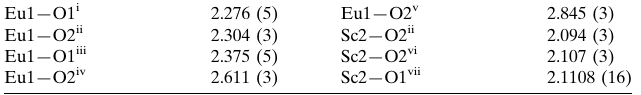
Selected bond lengths (A˚